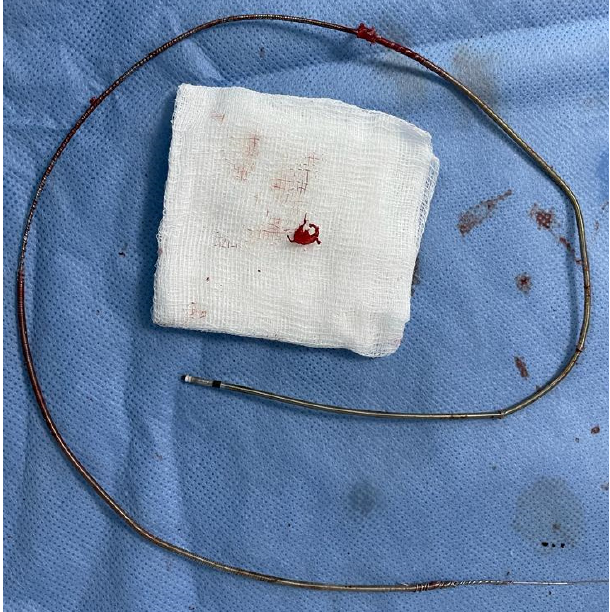
Figure 6. Extracted ventricular lead with large deposits of fibrin. The outer sheath of the Evolution RL system was kept at the RA level. Two 0.035 ′′ /180cm J-tip guidewires were inserted in the RA through this sheath. Afterward, the